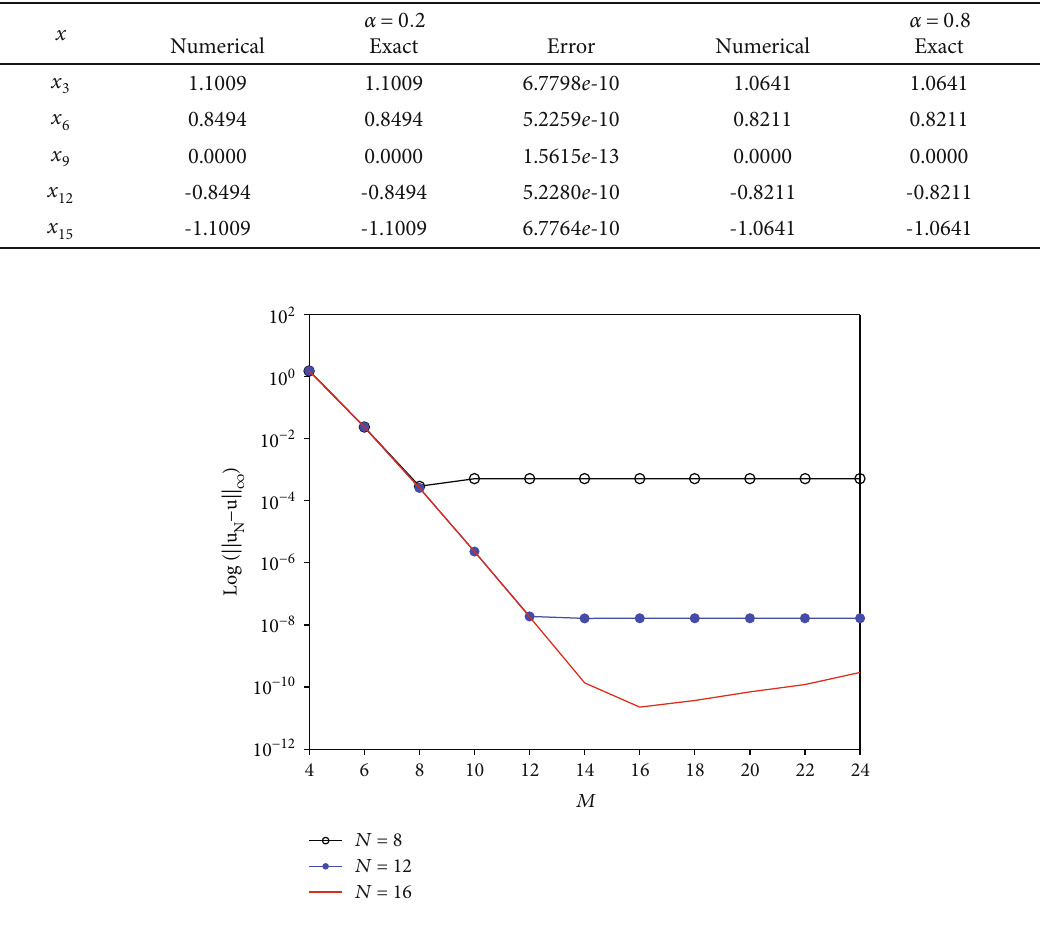
Figure 3: Log-linear plots of the maximum absolute error against M with di ff erent N